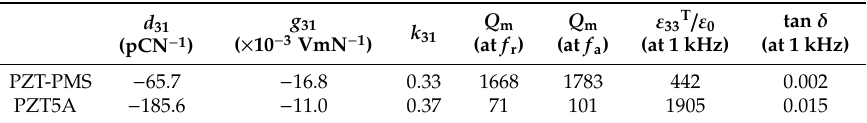
Table 1. Piezoelectric charge coe ffi cient ( d 31 ), piezoelectric voltage coe ffi cient ( g 31 ), electromechanical coupling coe ffi cient ( k 31 ), mechanical quality factors at the resonance frequency ( Q m at f r ) and anti-resonance frequency ( Q m at f a ), dielectric constant ( ε 33T / ε 0 ), and dissipation factor (tan δ ) of 31-mode PZT-PMS and PZT5A ceramics.